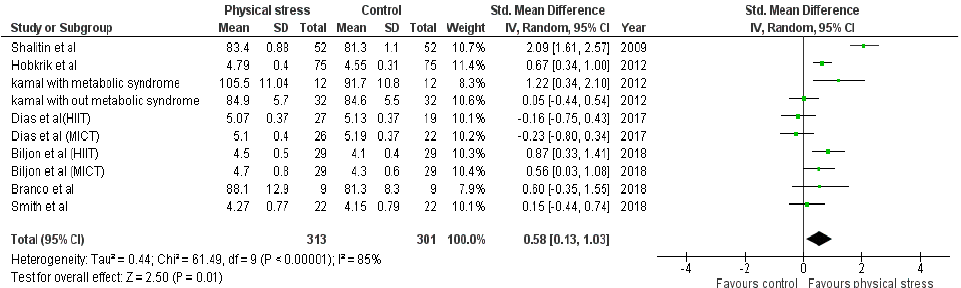
Figure 8. Forest plot showing the results for blood glucose.